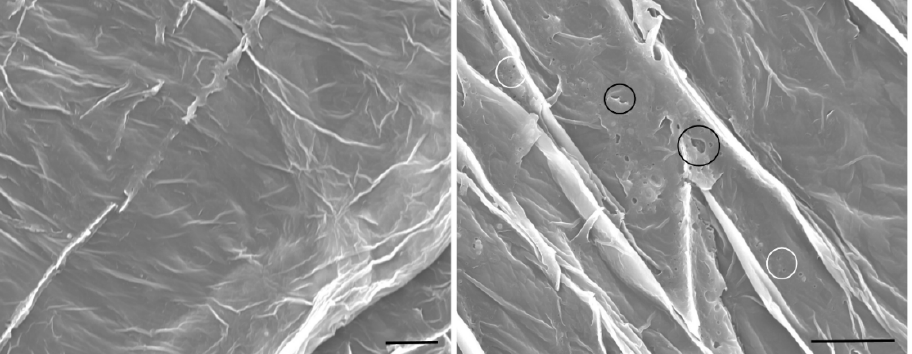
Figure 3. Scanning electron micrographs showing the effect of GVPs on S. litura peritrophic membrane (PM). (Left) PM of control larvae. (Right) PM of larvae treated with GVPs. White circles indicate small holes and black circles indicate larger holes. The black line corresponds to 10 μm.